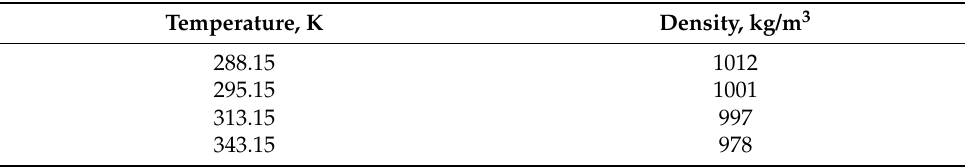
Table 4. Temperature-dependent Cold Lake bitumen oil density.